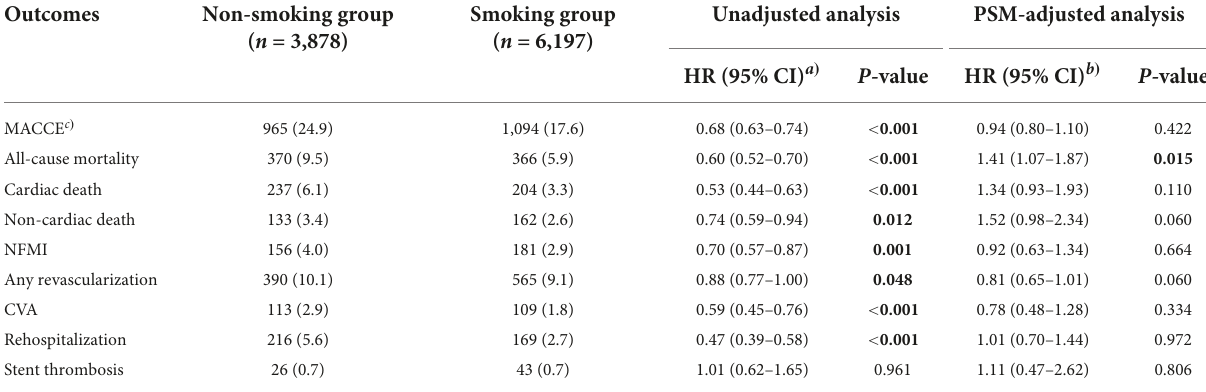
TABLE 3 Three-year clinical outcomes in propensity score matched patients.